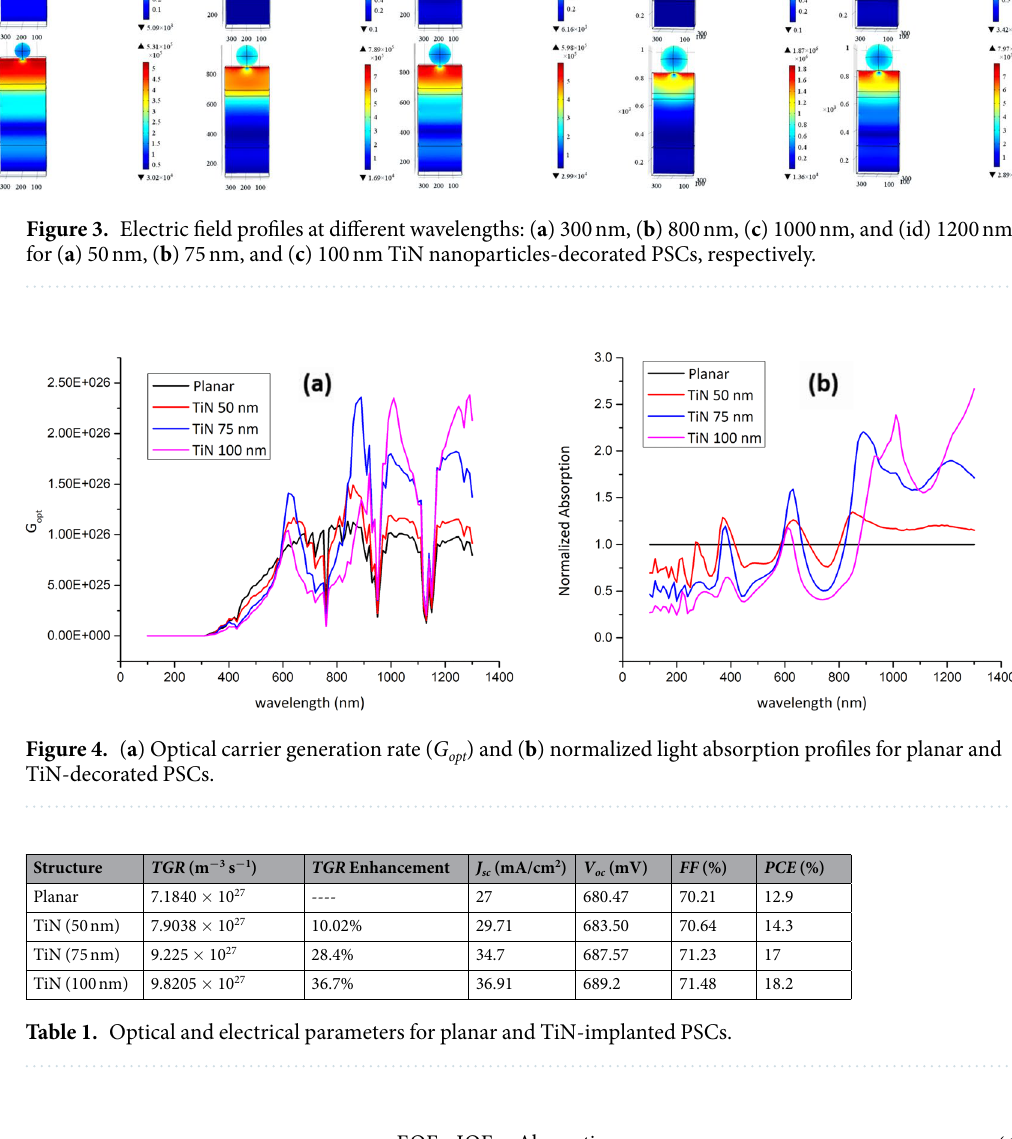
Table 1. Optical and electrical parameters for planar and TiN-implanted